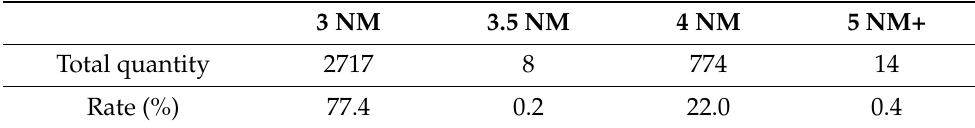
Figure 8. Probability density distributions of t ROT and t IAT . Table 5. Statistics for RECAT separation minima applied for aircraft pairs arriving at